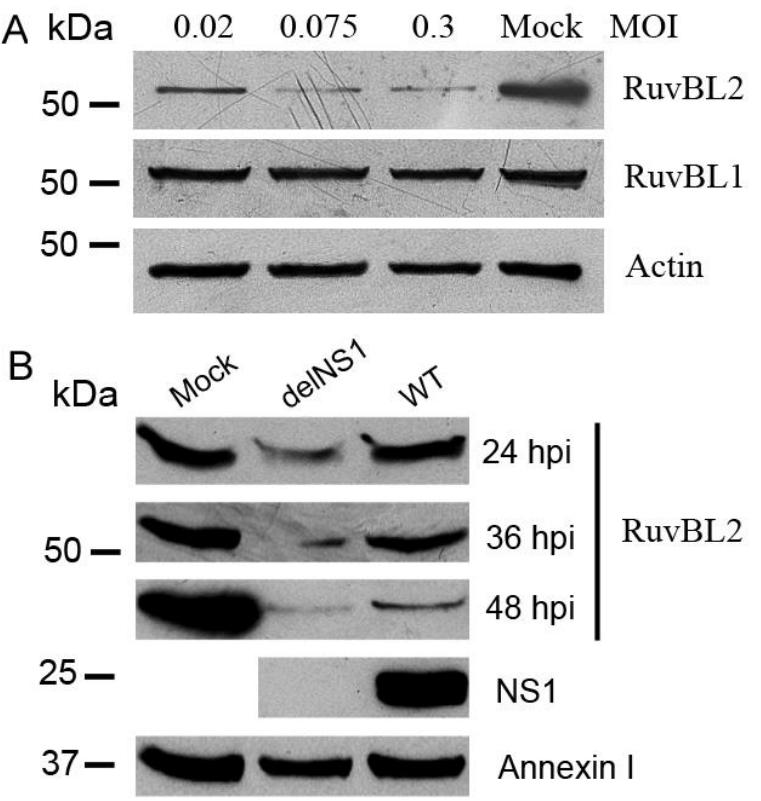
Figure 5. IAV infection suppresses cellular RuvBL2 protein abundance, and the NS1 protein acts to maintain RuvBL2 protein abundance. ( A ) IAV virus infection suppresses the protein levels of RuvBL2 but not RuvBL1 in A549 cells. A549 cells were mock-infected or infected with WT PR8 virus at the indicated MOIs for 36 h and the lysates were analyzed by Western blotting with the indicated antibodies. β-actin was used as a loading control. ( B ) IAV infection suppresses the protein levels of RuvBL2 in Vero cells and the NS1 protein acts to maintain RuvBL2 protein levels in infected cells. Vero cells were mock-infected or infected by WT or delNS1 PR8 virus at an MOI of 1 for 24, 36, or 48 h, and the cell lysates were then analyzed by Western blotting with the indicated antibodies. Annexin-1 was used as a loading control [38].